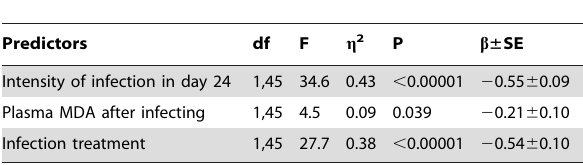
Table 3. Relationship between change in infection intensity between day 44 (last sampling of infection) and day 24 (before infecting) and plasma MDA levels at second blood sampling in an ANCOVA adjusting for a initial value of infection intensity and infection treatment. Interaction terms with infection treatment were not significant (P .